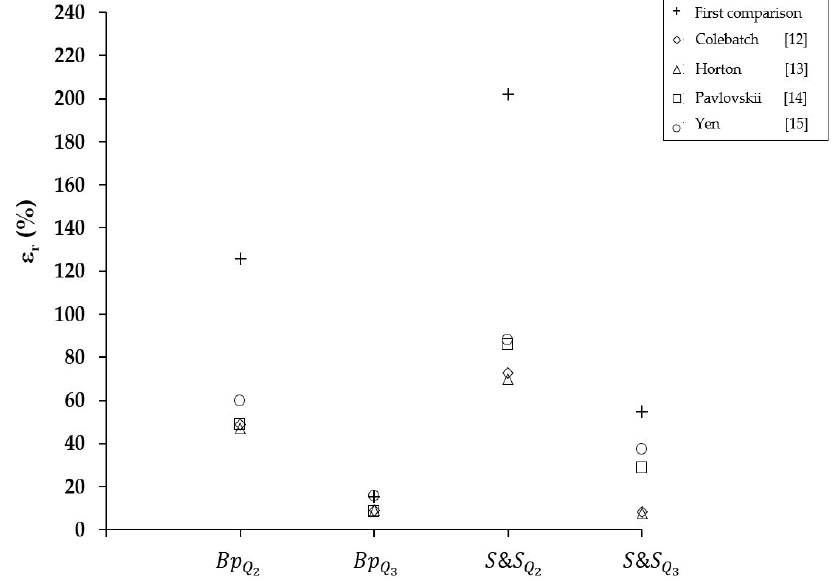
Figure 10. Relative prediction errors ε r (%) of Bp and S&S resistance predictor models [8,9], computed under the two flow rate regimes respectively pair to Q 2 = 0.16 m 3 ·s − 1 and Q 3 = 0.33 m 3 ·s − 1 , corresponding to the condition of partial riparian vegetation coverage of the reclamation channel, without employing the proposed methodology (black crosses), and by applying the four examined composite cross section methods: Colebatch [12] (diamonds), Horton [13] (triangles), Pavlovskii [14] (squares), and Yen [15] (circles).